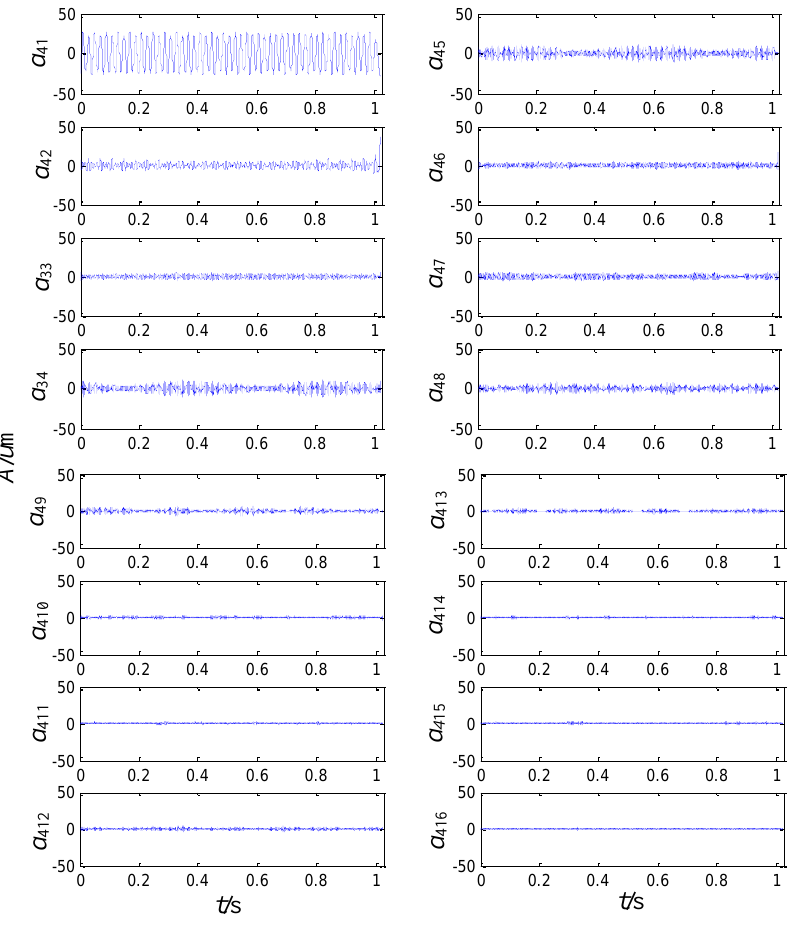
Figure 19. Signals analysis by second generation wavelet package in level 4 after